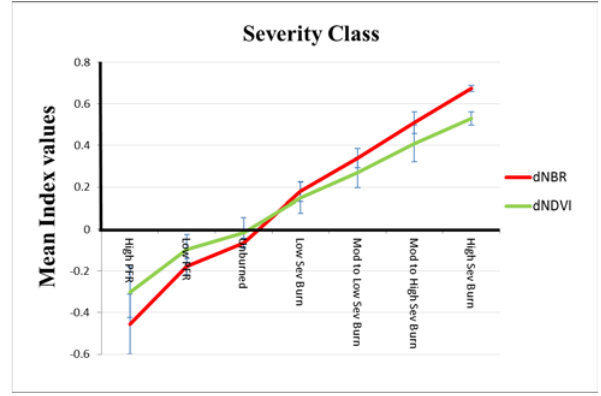
Figure 6. Feb to May mean dNBR and mean dNDVI in Tarlac showing positive correlation (p = 0.004) between indices.